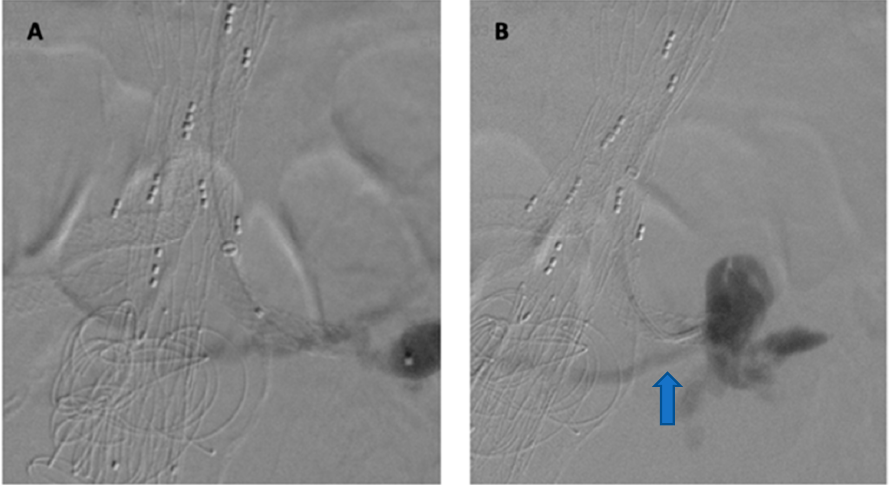
Figure 5. ( A , B ) Distal left renal artery rupture after bridging stent deployment during a TAAA repair, as observed on selective angiography (blue arrow).